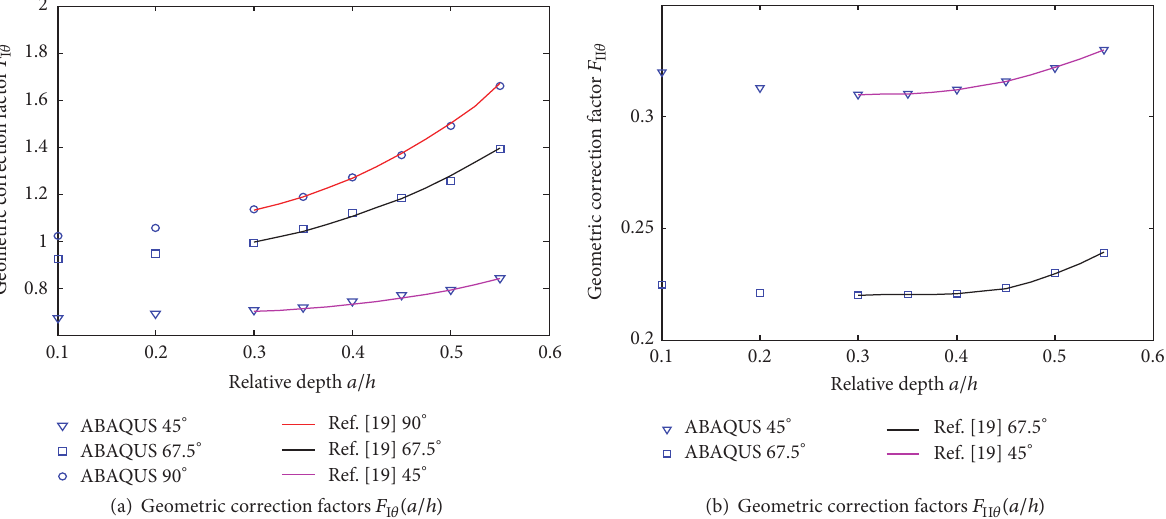
Figure 4: Geometric correction factors 𝐹 Ι𝜃 (𝑎/ℎ) and 𝐹 ΙΙ𝜃 (𝑎/ℎ) .